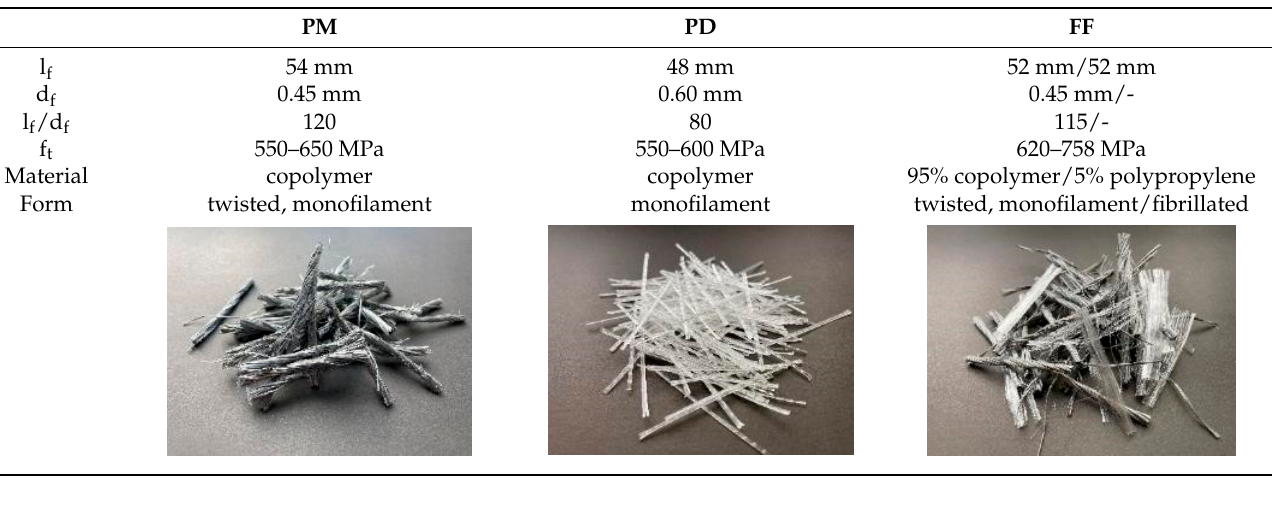
Table 2. Characterization of fiber properties.